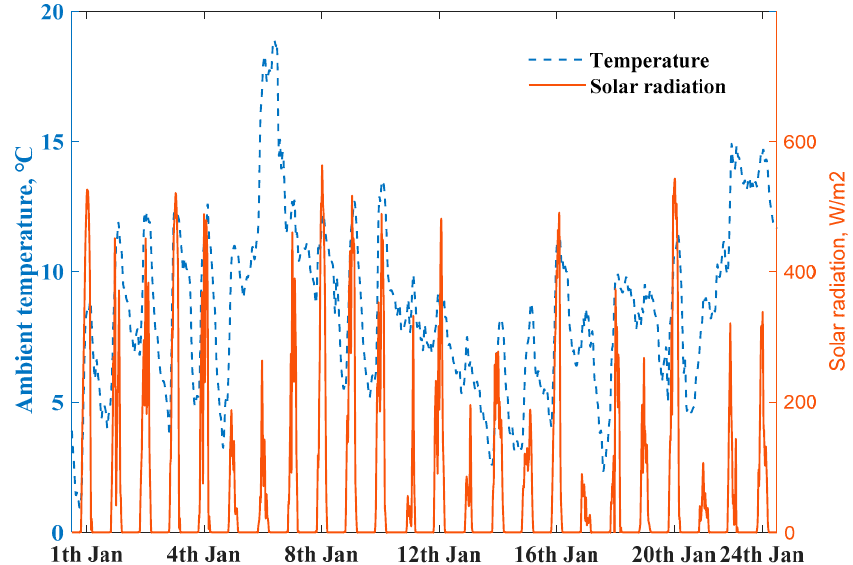
Figure 8. Solar radiation and ambient air temperature profiles.